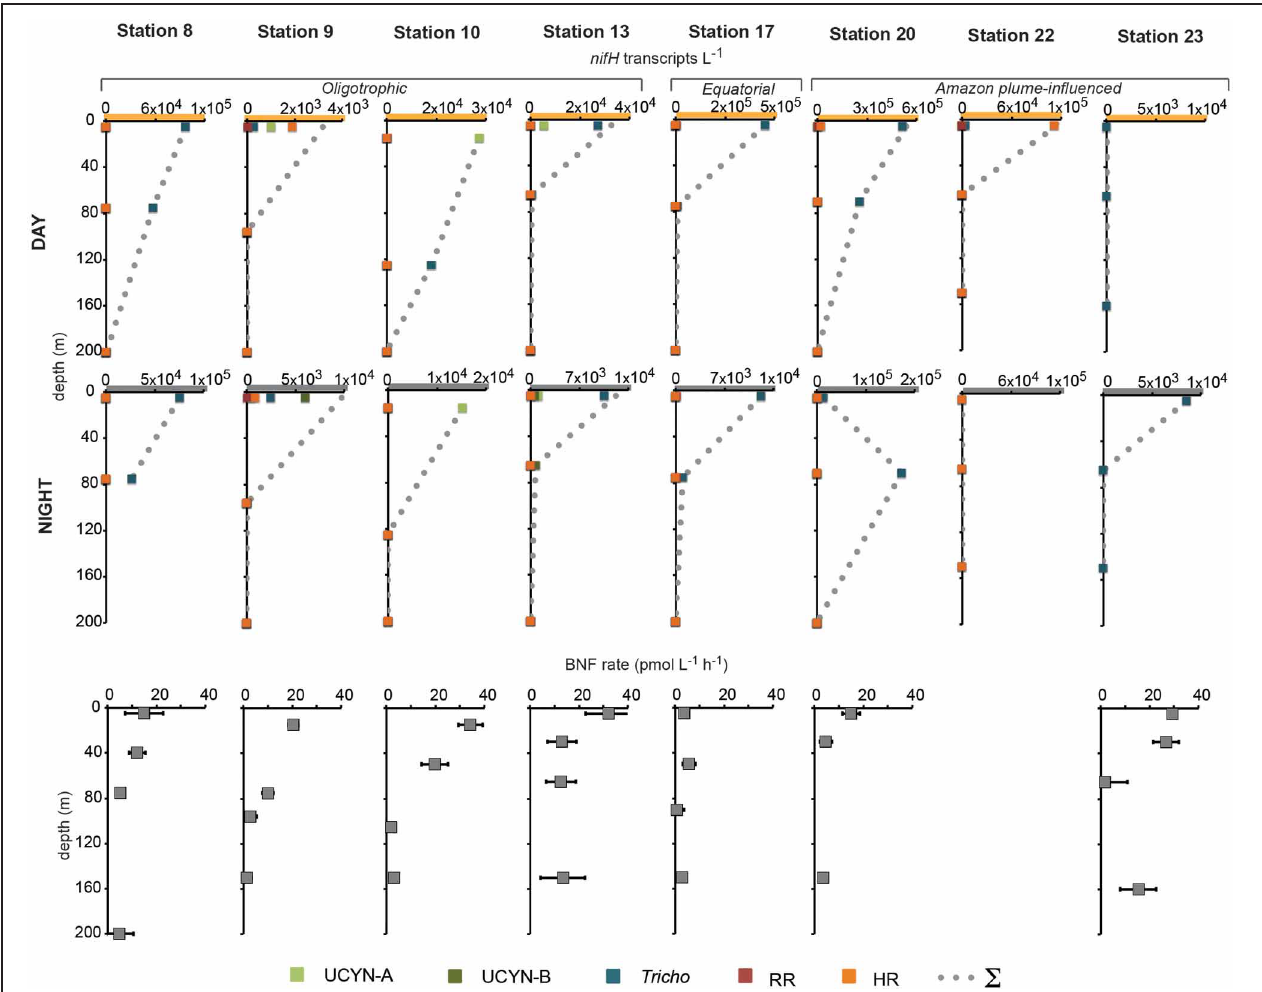
unicellular cyanobacteria group A; UCYN-B, uncultivated unicellular cyanobacteria group B; Tricho , Trichodesmium ; RR, Richelia in Rhizosolenia (Het-1); HR, Richelia in Hemiaulus (Het-2); and (cid:2) , sum of all nifH transcripts L − 1 for both size-fractions quantified at each station and depth.